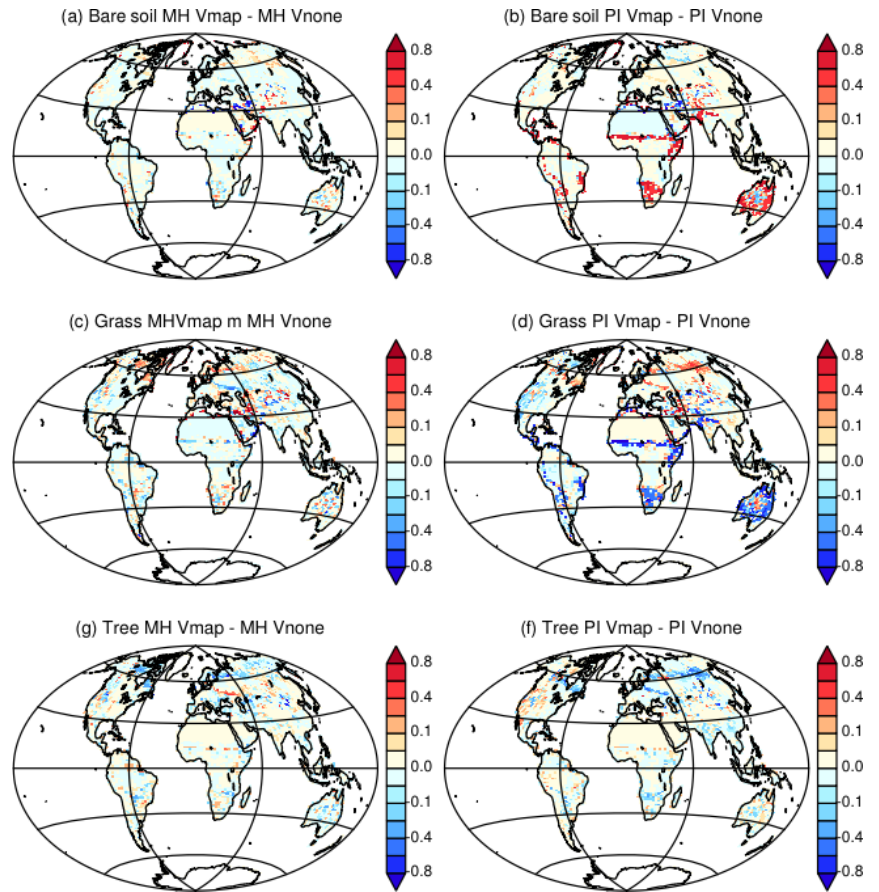
Figure 16. Difference between Vegetation maps obtained with the two different initial states for (a, c, e) Mid-Holocene simulations and (b, d, f) preindustrial simulations. Vmap stands for MH and PI simulations where the Mid-Holocene vegetation has been initialized from a vegetation map and Vnone for MH and PI simulations where the Mid-Holocene has been initialized from bare soil. For simplicity we only consider fractions of (a, b) bare soil, (c, d) grass, and (e, f)